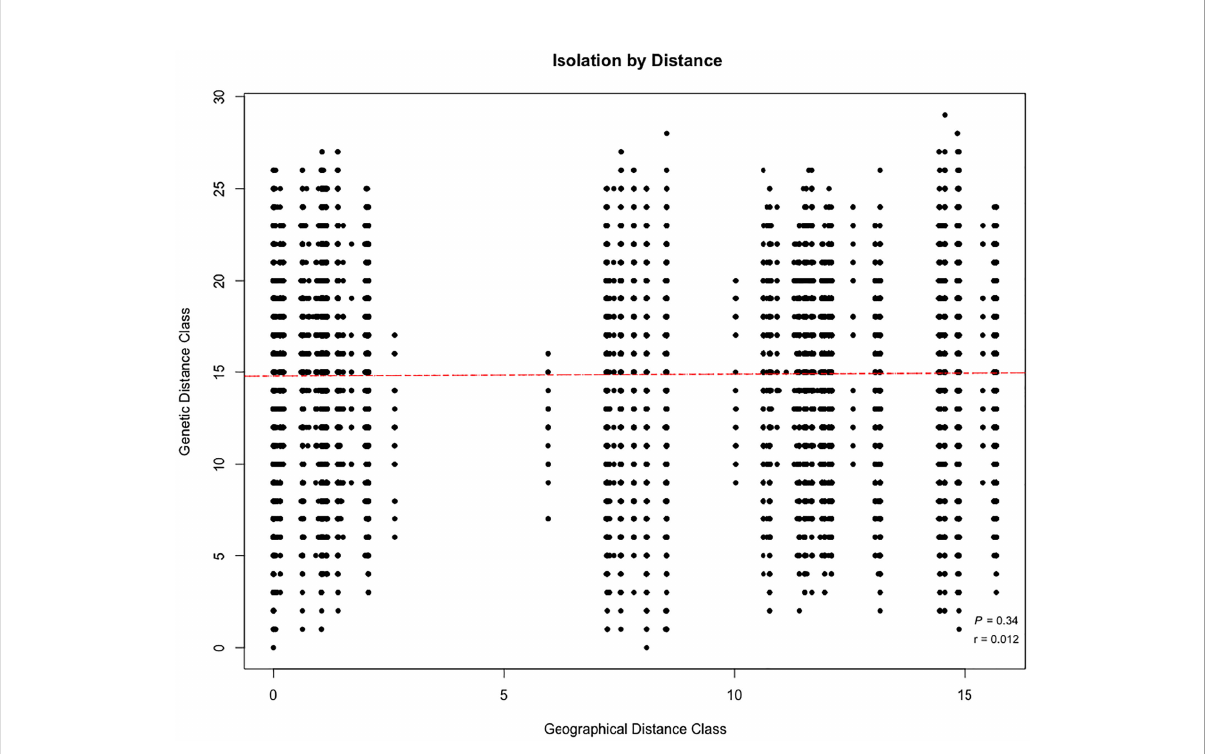
FIGURE 3 Pairwise genetic and geographical distances of 179 Cryptolepis sanguinolenta samples collected from 8 subpopulations in Ghana displayed as a